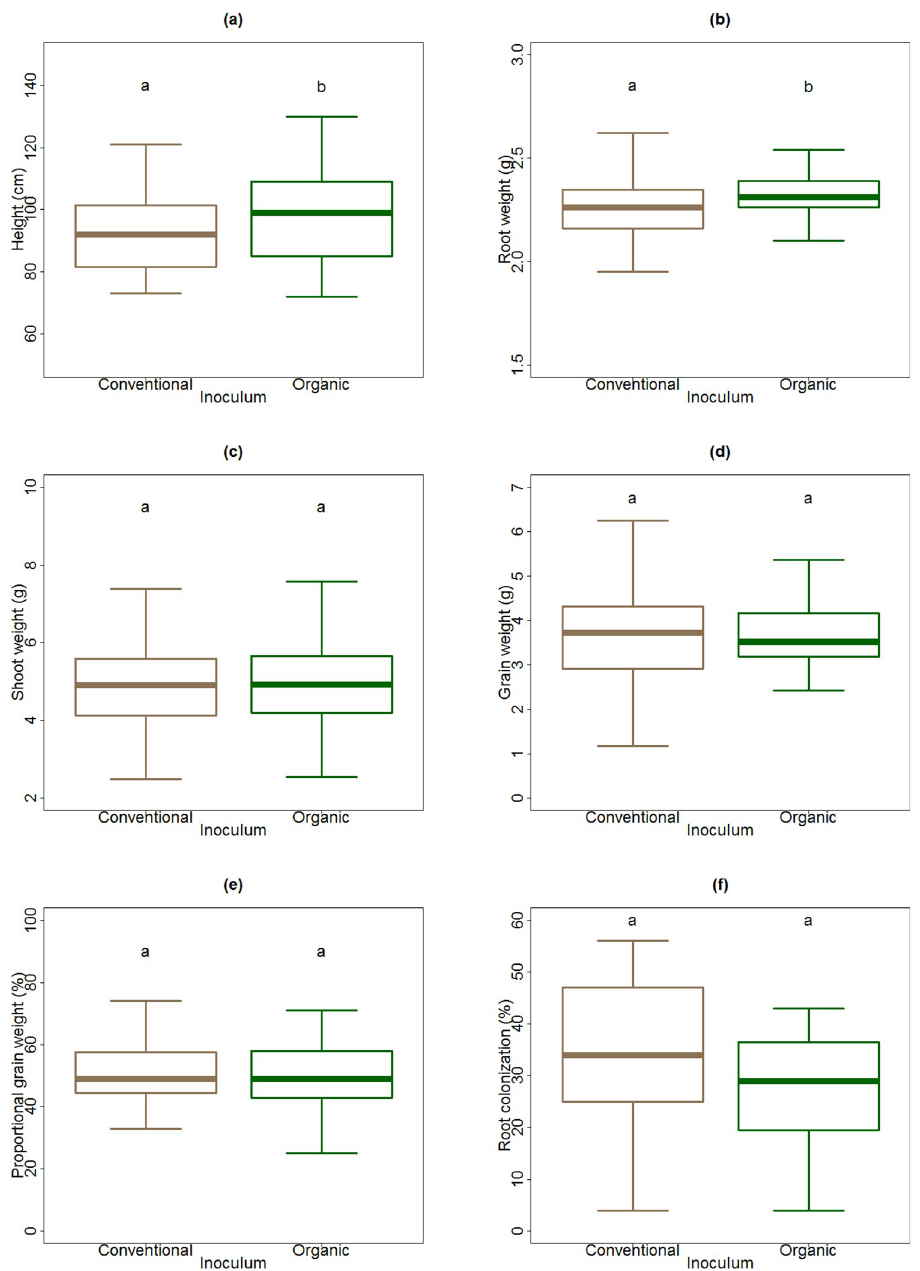
Fig 2. Effect of inoculum type (soil from conventionally or organically managed field) on plant traits: Height (a), root weight (b), shoot weight (c), grain weight (d), proportional grain weight (e), and root colonization (f). Thick lines represent medians; boxes indicate interquartile ranges; and whiskers show maximum and minimum values per sample. 1.83, P = 0.11, Fig 4b). Organic field inoculum increased the shoot weight of Pikker 1959 and Ta¨hti 1972, while it decreased the shoot weight of all other four cultivars (F P < 0.01, Fig 4c). Although, interactions between inoculum type and cultivar were significant for grain weight (F = 9.36, P < 0.01, Fig 4d) and proportional grain weight (F 5,104 P < 0.01, Fig 4e), there were no clear patterns observed in relation to the age of the cultivar.